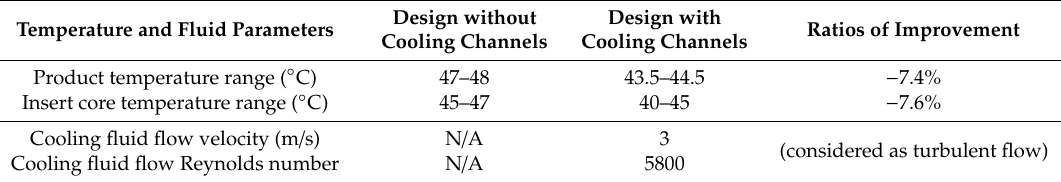
Table 4. Information about the temperature ranges, the cooling fluid flow constants, and their ratios of improvement of the initial insert designs (without cooling channels) and the redesigns (with cooling channels).